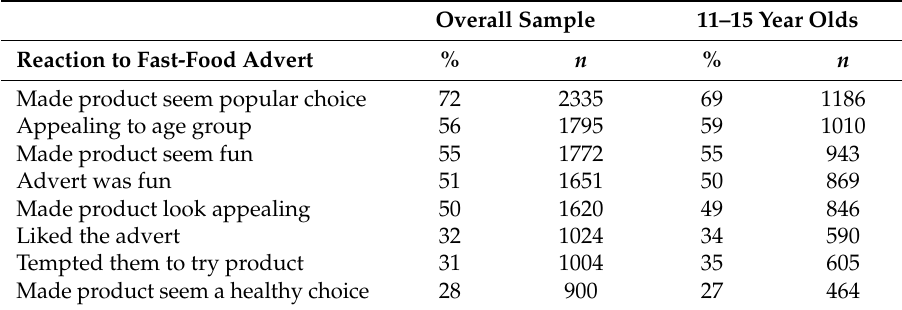
Table 2. Positive reactions to the fast-food